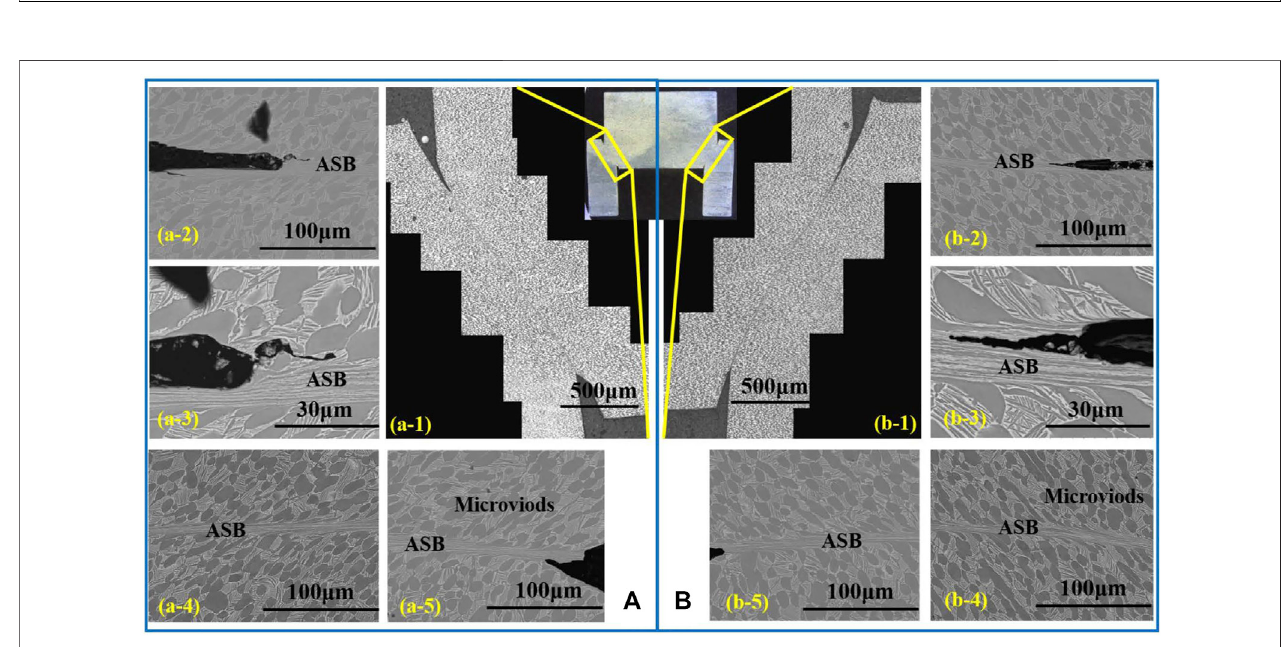
FIGURE5| Themulti-scalesSEMcharacterizationsofadiabaticshearbandsinthehat-shapedspecimenatstrainrateof2.0×10 4 s − 1 s − 1 , (A) theleftpart; (B) the right part. The additional numbers identify the typical features of selected